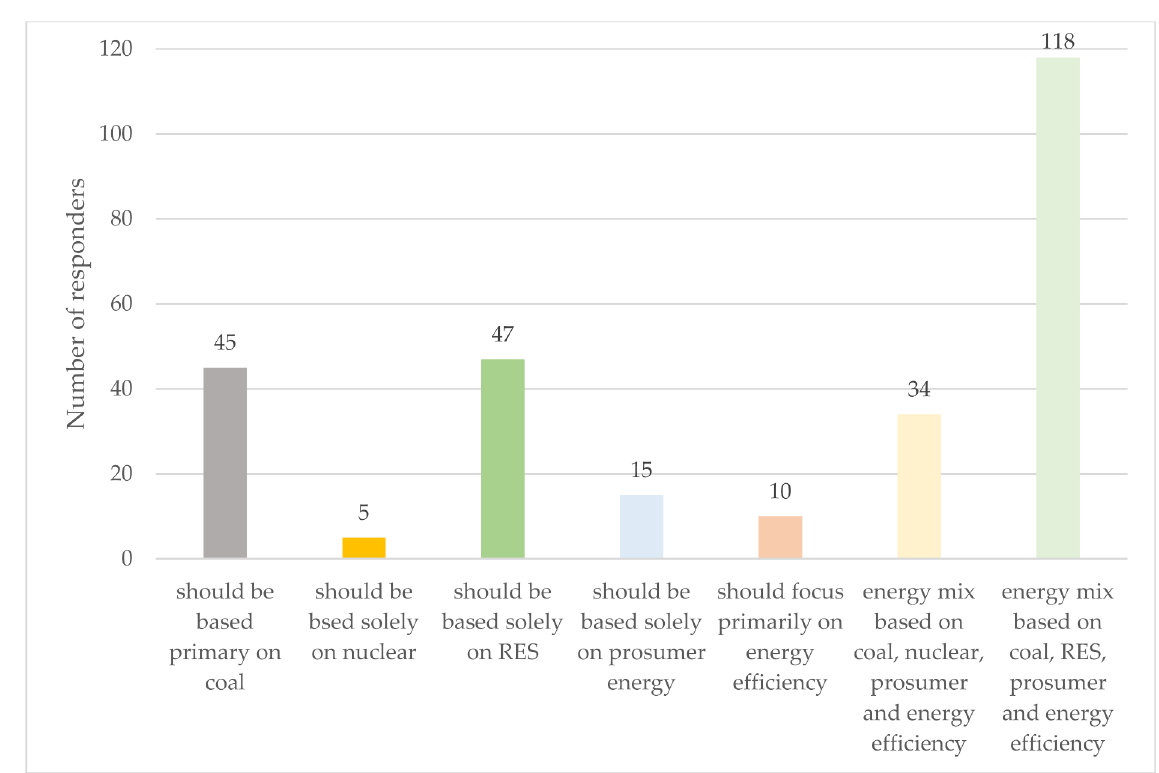
Figure 12. Opinion on the optimal energy mix for Poland. Respondents could select only one answer. Source: own